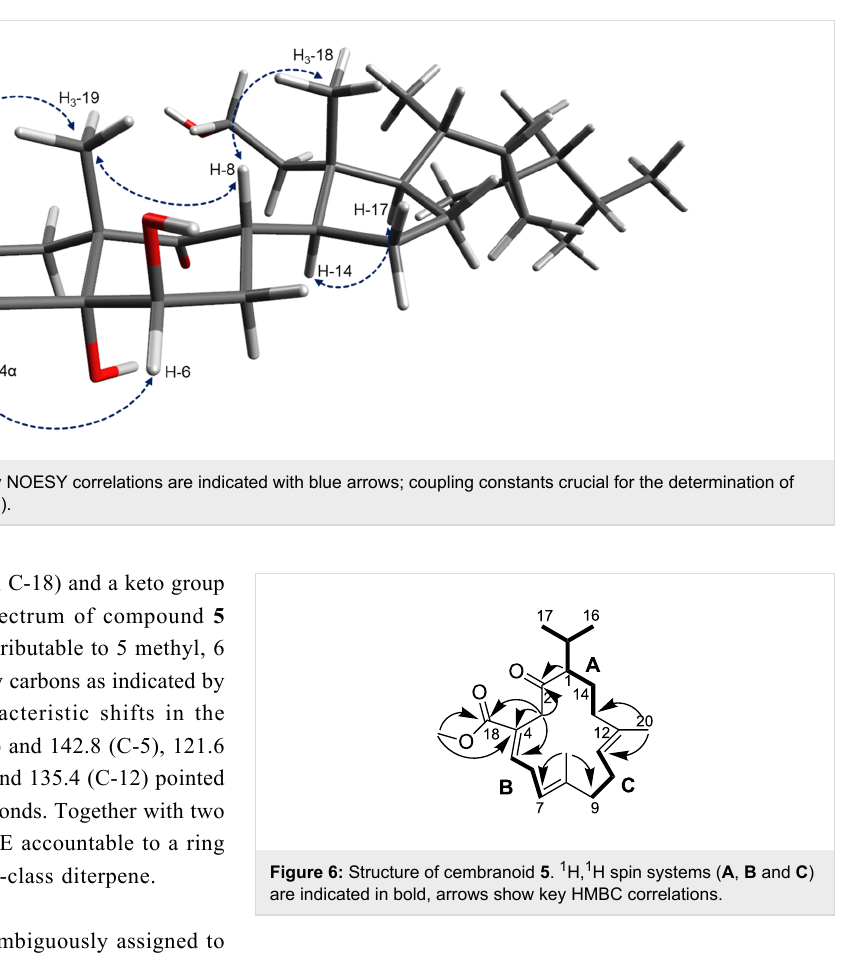
and tertiary carbon C-5 and with the ester carbonyl C-18. Due to the deshielded nature and large 1 H-coupling constant (signals of both protons appear as doublets, J = 17.7 Hz at δ H 3.49 and 3.64) of the 1 H NMR resonance of the H 2 -3, the position of